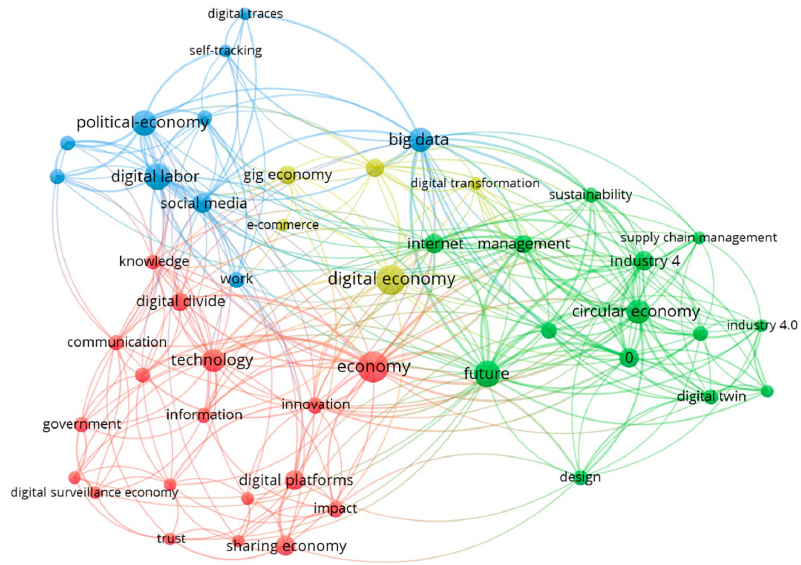
Figure 2. Analysis of digital economy focus areas (source: Web of Science